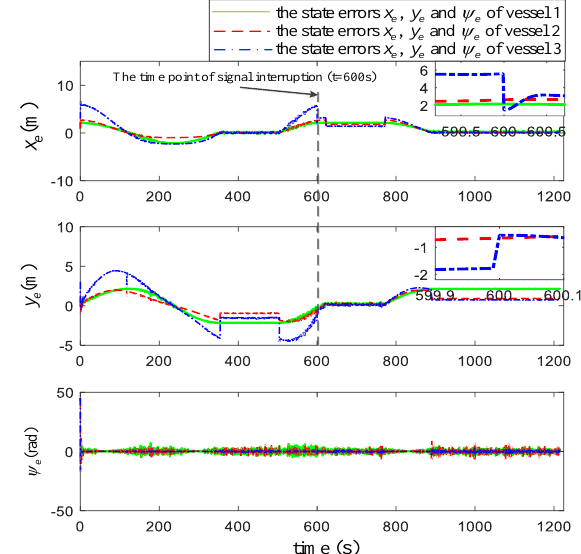
Figure 5. The position and orientation errors for the formation.